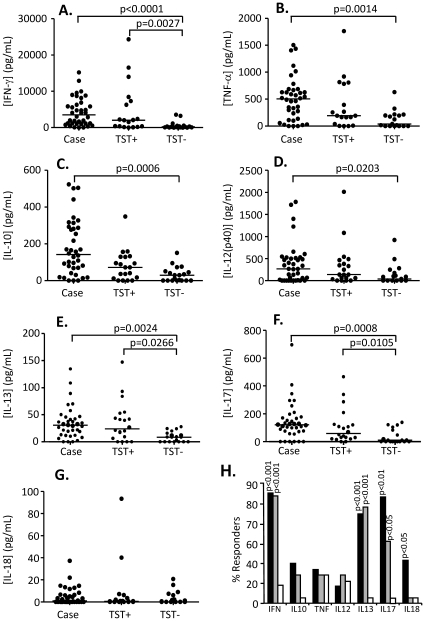
Cytokine responses following PPD stimulation.Whole blood from TB cases (n = 36), TST+ (n = 20) and TST− (n = 19) contacts was stimulated for 7 days with PPD and the supernatant assessed by multiplex cytokine analysis. A) IFN-γ. B) TNF-α, C) IL-10, D) IL-12(p40), E) IL-13, F) IL-17 and G) IL-18. Line indicates median. Data were analysed using Tweedie distributions with p-values indicating significant differences after adjustment for age and sex. H) Percentage of responders producing IFN-γ, IL-10, TNF-α, IL-12, IL-13, IL-17, IL-18. Dark bars = cases, grey bars = TST+ contacts, white bars = TST− contacts; p-values are indicated and refer to comparison with TST− contacts.